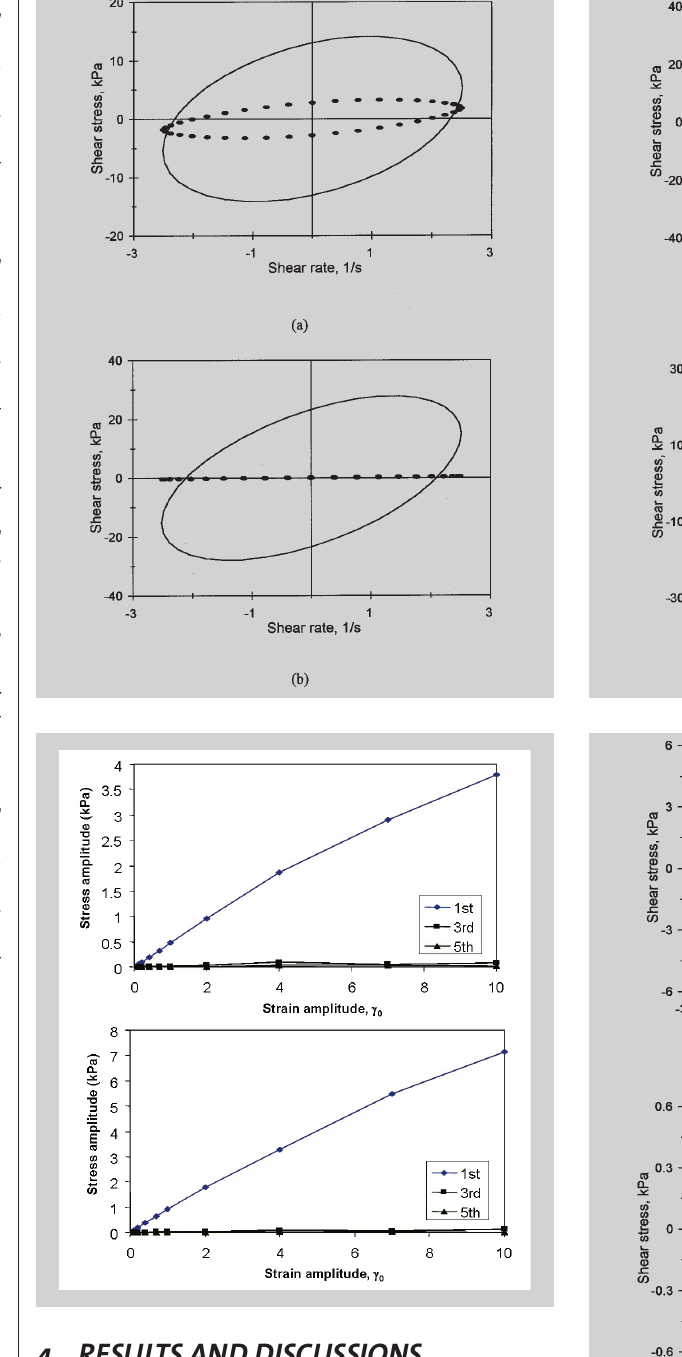
Figure 2 (left above): The experimental ( ∑ ) and predicted (lines) shear stress versus shear strain rate loop for Cheddar cheese at a.) 40˚C and b.) 60˚C using the relaxation spectrum determined from SAOS test (0.4 Hz and g 0 = 0.01). Figure 3 (right above): The experimental ( ∑ ) and predicted (Lines) shear stress versus shear strain rate loop for Mozzarella cheese at a.) 40˚C and b.) 60˚C using the relaxation spectrum determined from SAOS test (0.4 Hz and g 0 = 0.01). Figure 4 (left below): Shear stress versus shear strain data for 6-week-old reduced-fat Cheddar cheese at and 60˚C at 0.4 Hz (top) and 0.8 Hz (bottom) over g 0 = 0.1 to 10. The virtual absence of 3rd and 5th harmonics indicates linear viscoelastic properties at large strain amplitudes. Figure 5 (right below): The experimental ( ∑ ) and predicted (lines) shear stress versus shear strain rate loop for Cheddar cheese at a.) 40˚C and b.) 60˚C using the relaxation spectrum determined from LAOS test ( 0.4 Hz and g 0 =